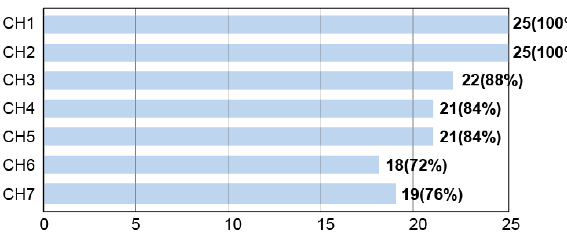
Figure 5. Participation of the students on seven meetings delivered through Passion in Action